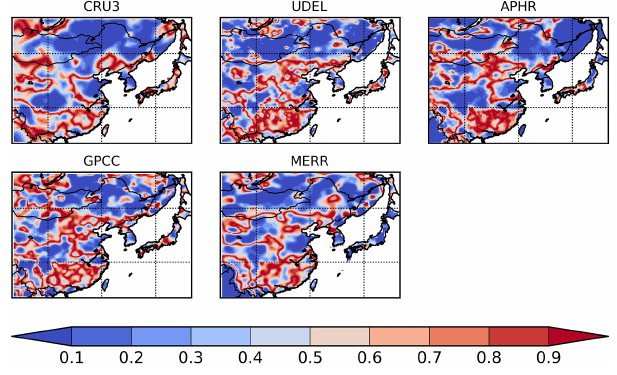
Figure 3. The p values in calculating the linear trend of the annual- mean precipitation from each data set.